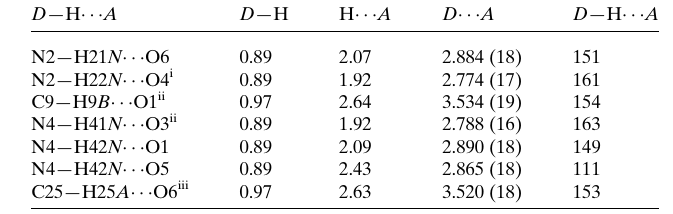
which involve the water molecule, and R 2 molecule. This combination of R 3 ribbons propagating in the a -axis direction. In addition, there